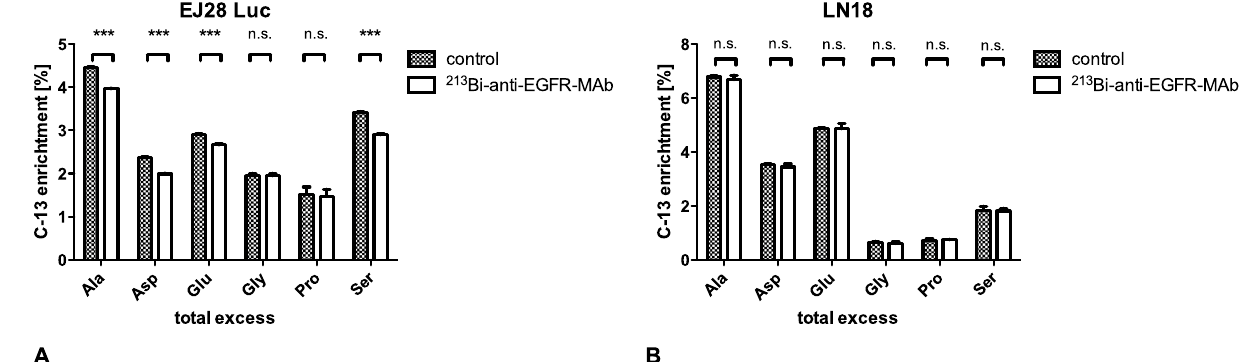
Figure 2. Overall enrichment of 13 C in analyzed amino acids of untreated control cells and 213 Bi-anti- EGFR-MAb treated cells. Results are shown for EJ28-Luc bladder cancer cells ( A ) and LN18 glioma cells ( B ). 213 Bi-anti-EGFR-MAb treatment of EJ28-Luc cells resulted in a significant decrease of 13 C-enrichment in alanine, aspartate, glutamate, and serine (***p < 0.0001 compared to controls). Moreover, we observed a slight (nonsignificant = n.s.) decrease in proline. Enrichment of 13 C varied from 1.6% in proline to 4.5% in alanine ( A ). In contrast, no significant changes were observed for LN18